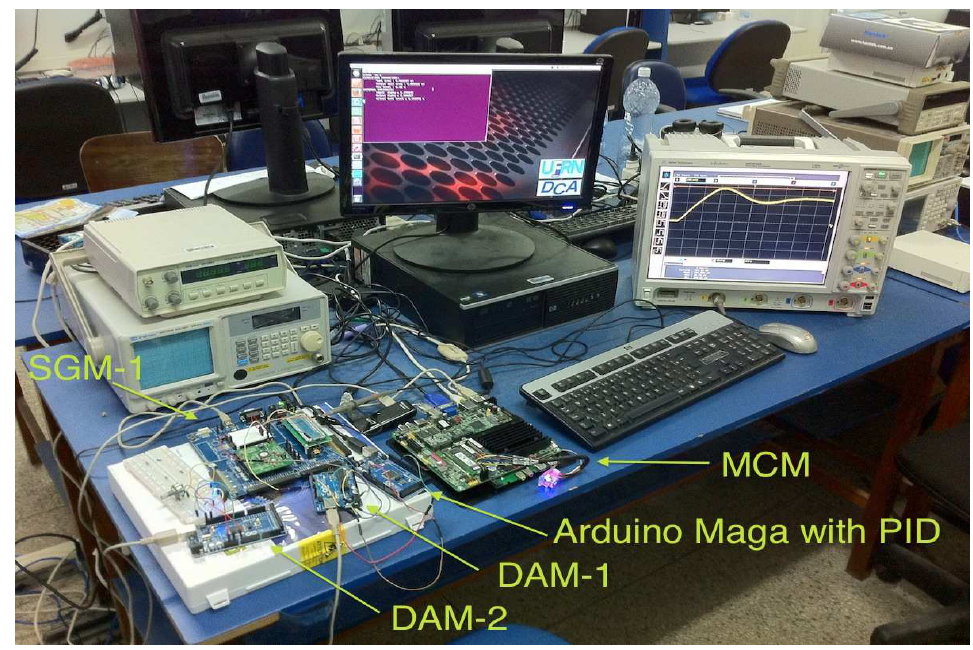
Figure 20. Equipment used in testing with the